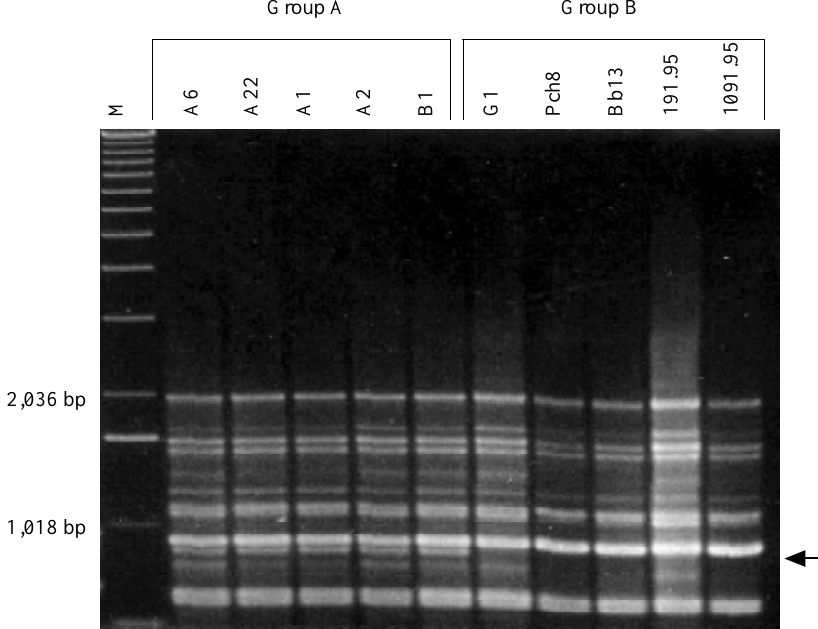
Fig. 2. Banding patterns of Phaeomoniella chlamydospora isolates generated by UP-PCR primer AS4 and separated by 1% agarose gel electrophoresis. M designates the 1 kb DNA ladder; size is shown at the left of the gel. Arrow indicates polymorphic